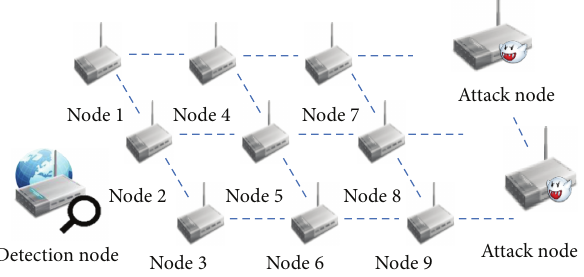
Figure 7: The schematic diagram of the test network.